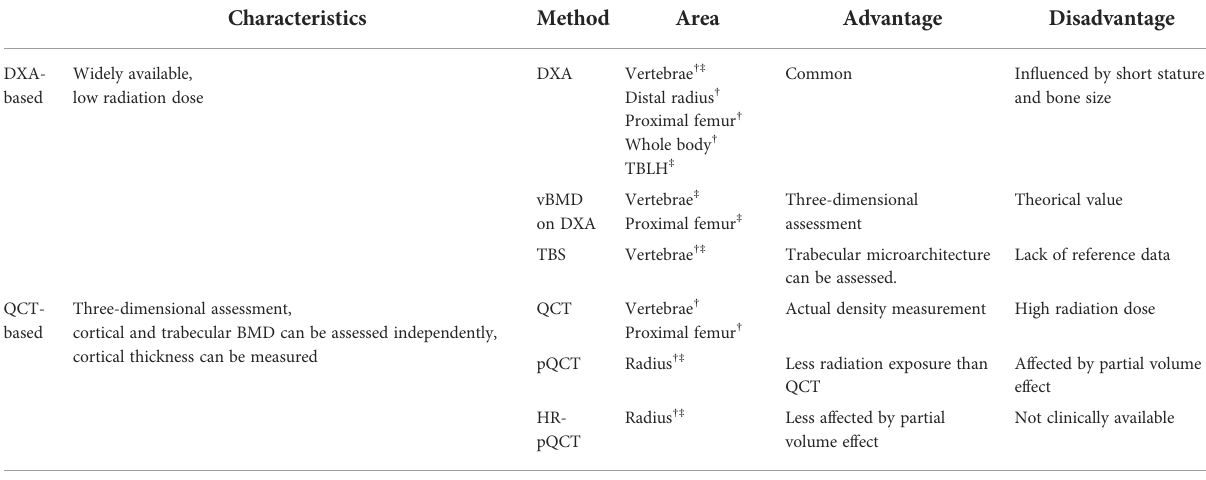
TABLE 2 Advantages and disadvantages of bone assessment methods in patients with